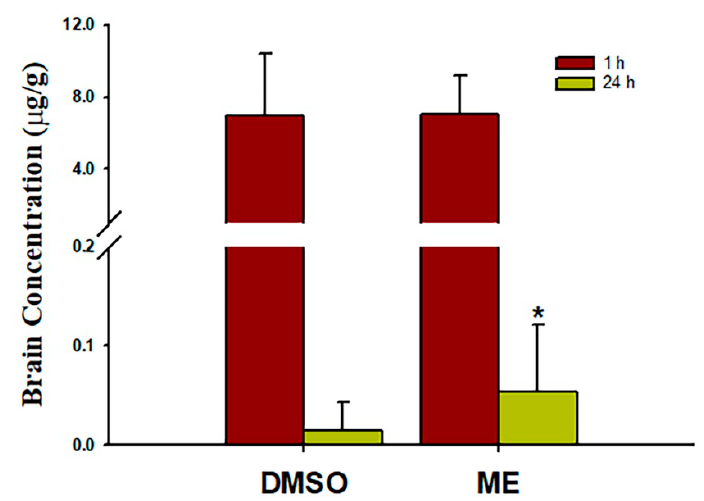
Figure 5. Mean brain magnolol concentrations in rats 1 and 24 h post-treatment with 30 mg / kg magnolol administrated intraperitoneally. Data are expressed as mean ± SD of three independent experiments. * p < 0.05. ME, microemulsion group.